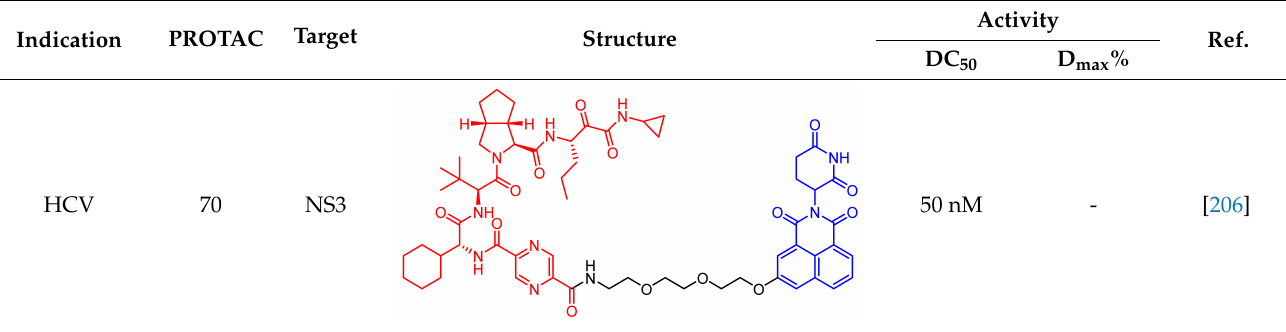
Table 5. Representative PROTACs for